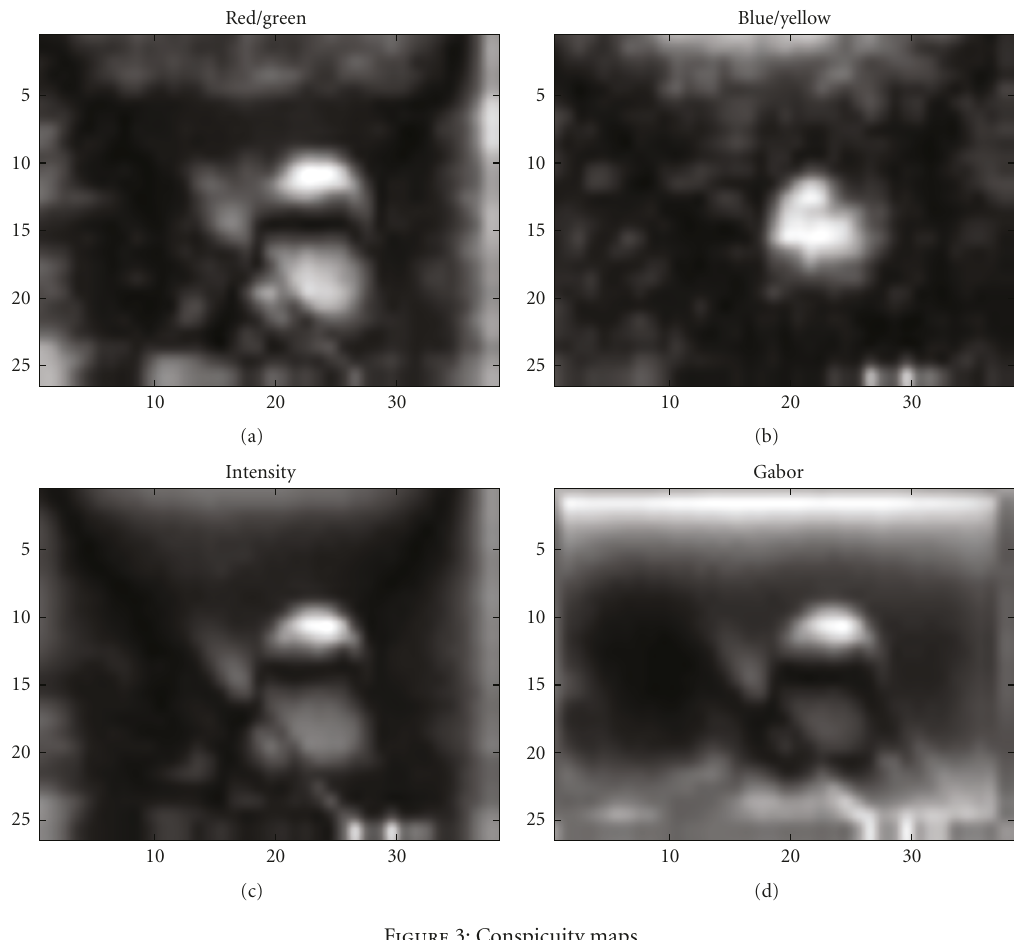
Figure 3: Conspicuity